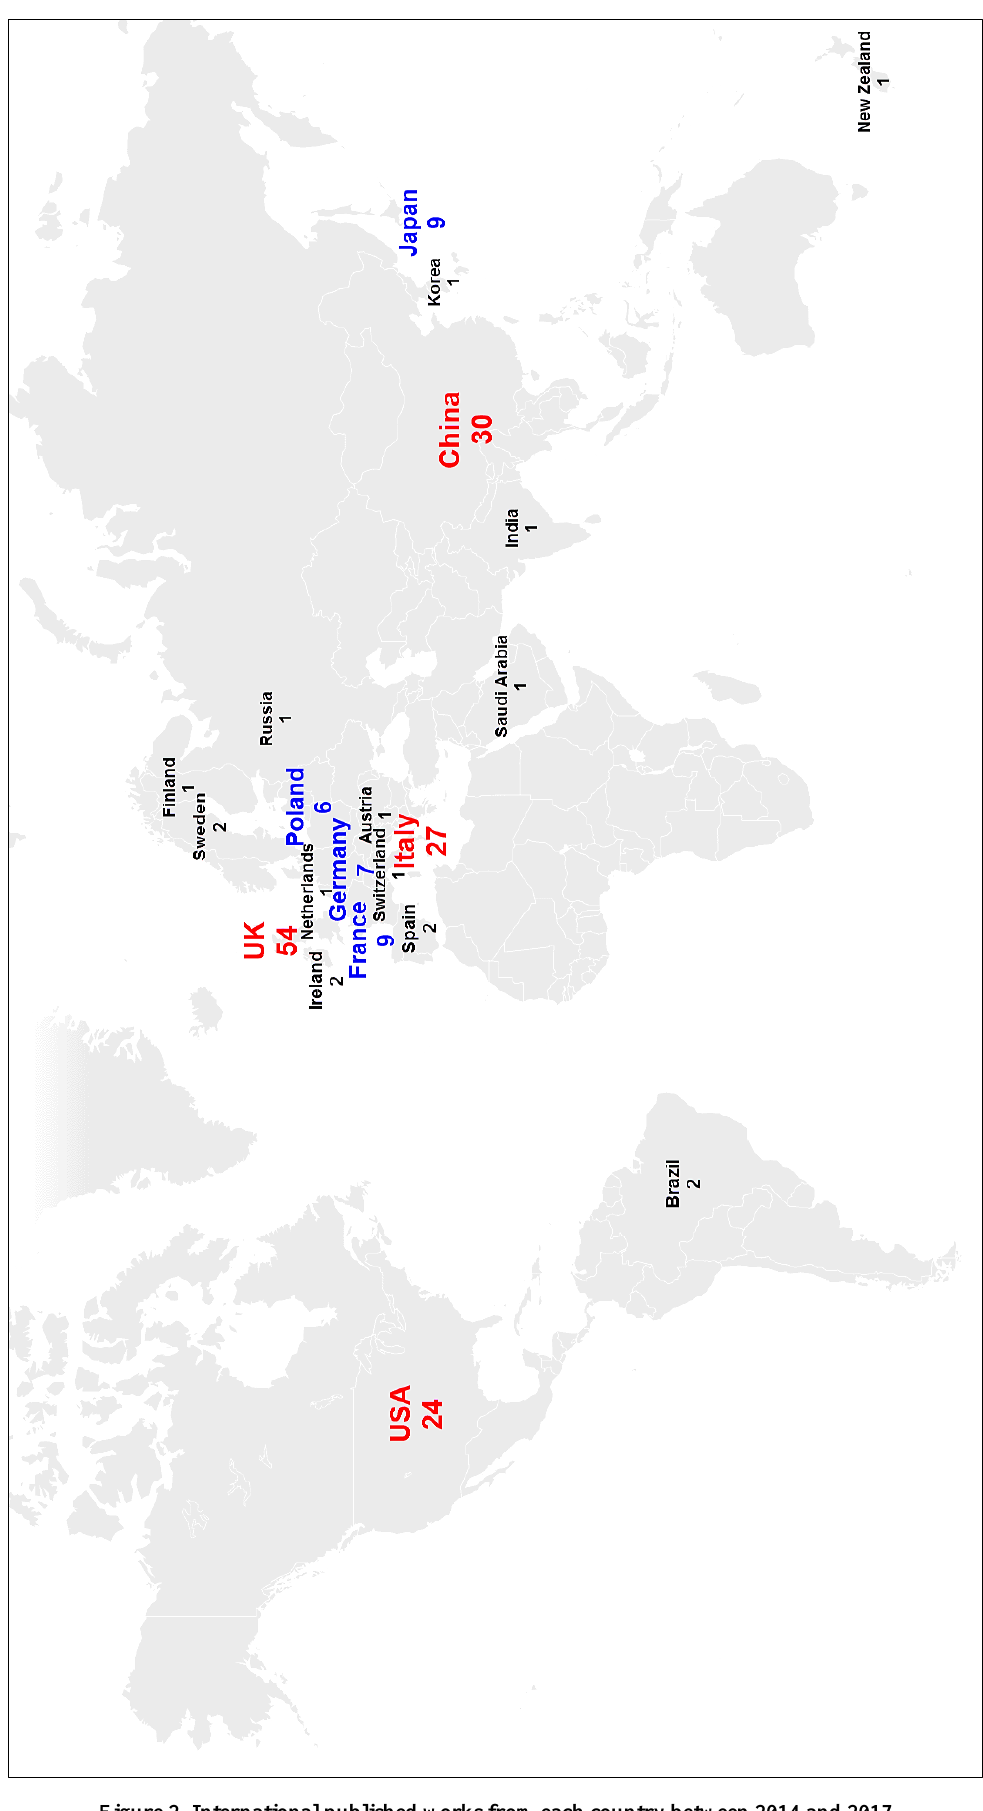
Figure 2. International published works from each country between 2014 and